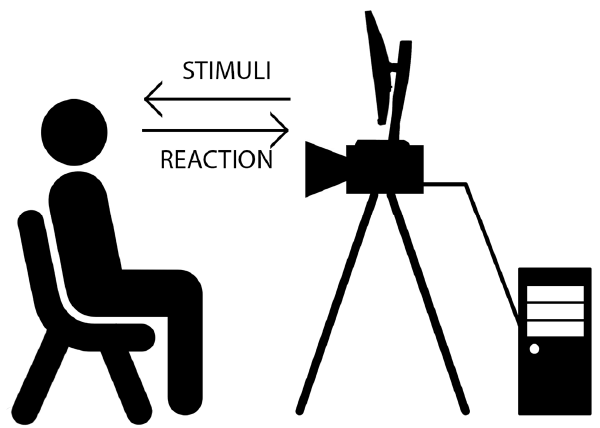
Figure 1. High-speed video acquisition and analysis process.